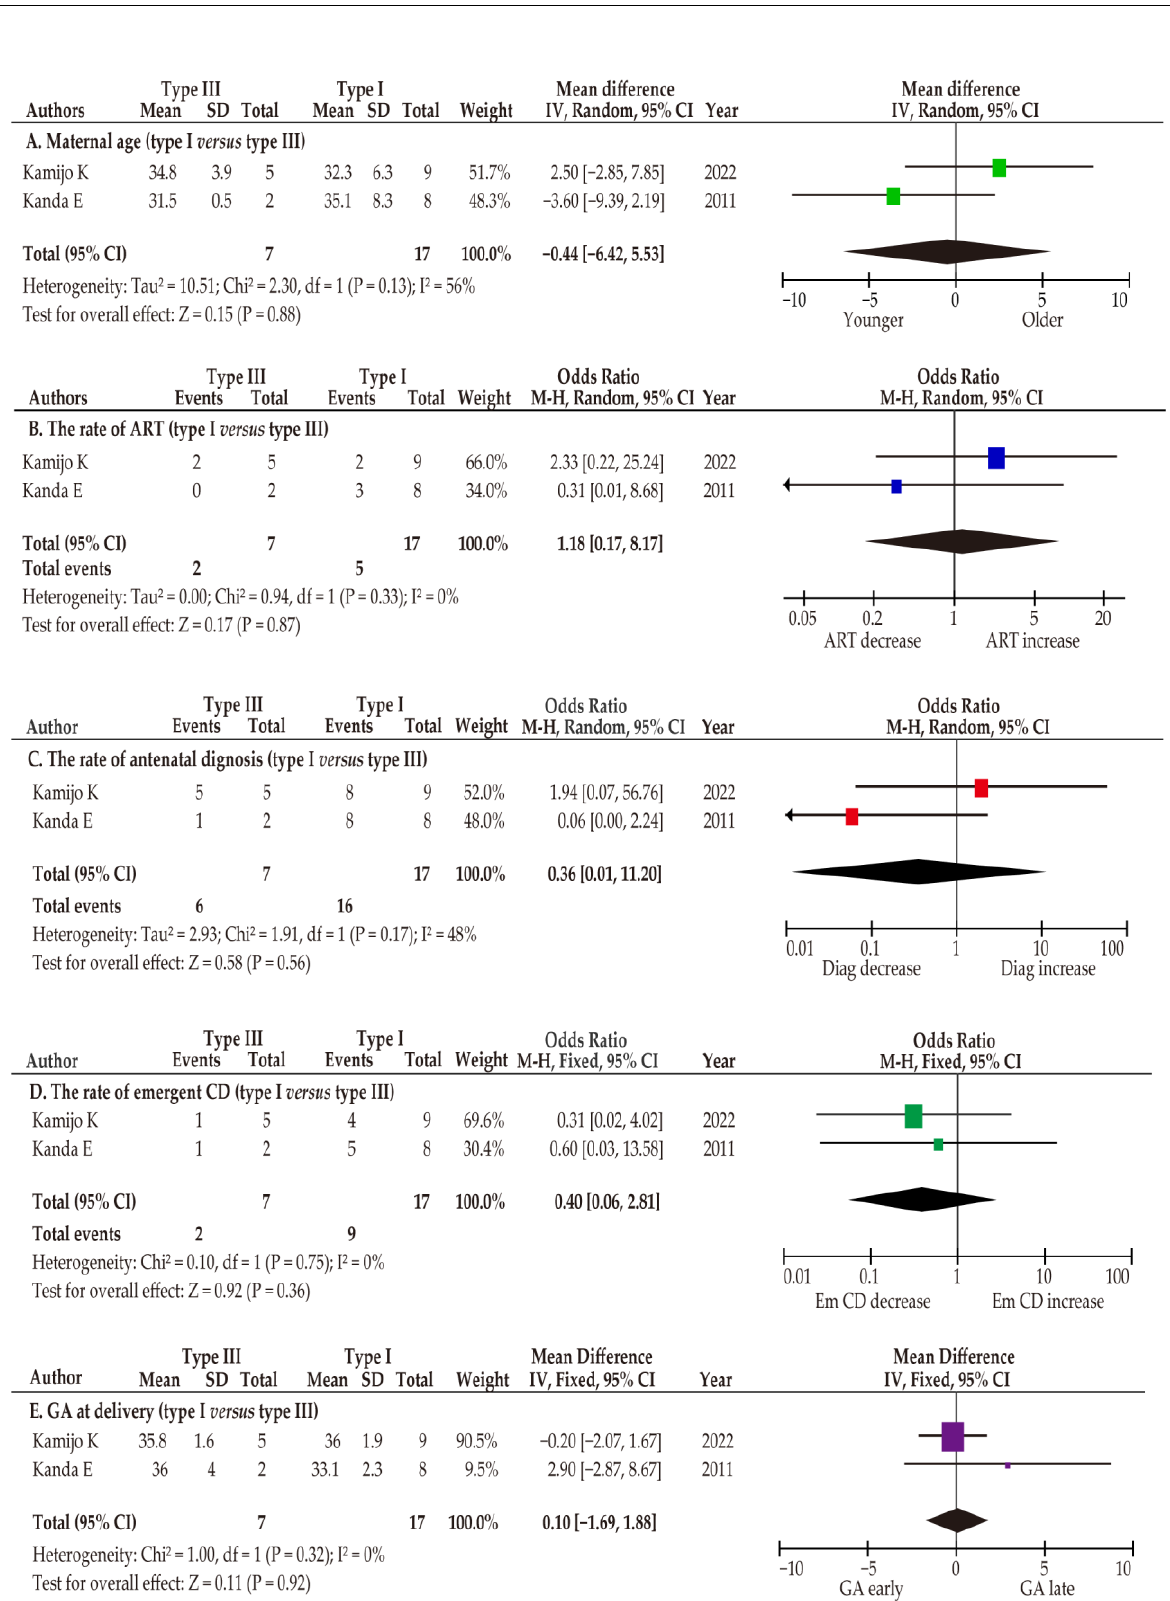
Figure 4. Meta-analysis of the characteristics and outcomes of types I and III vasa previa. Pooled odds ratios for ( A ) maternal age (years), ( B ) the rate of ART pregnancy (unadjusted), ( C ) the rate of antenatal diagnosis (unadjusted), ( D ) the rate of emergent cesarean delivery (unadjusted), and ( E ) gestational age at delivery (weeks) among patients with type I and type III vasa previa. The Forest Plot is ordered by publication year and relative weight (%) of the studies within the strata. The position of colored boxes is a point of the estimated odds ratio and the size represents the weight of